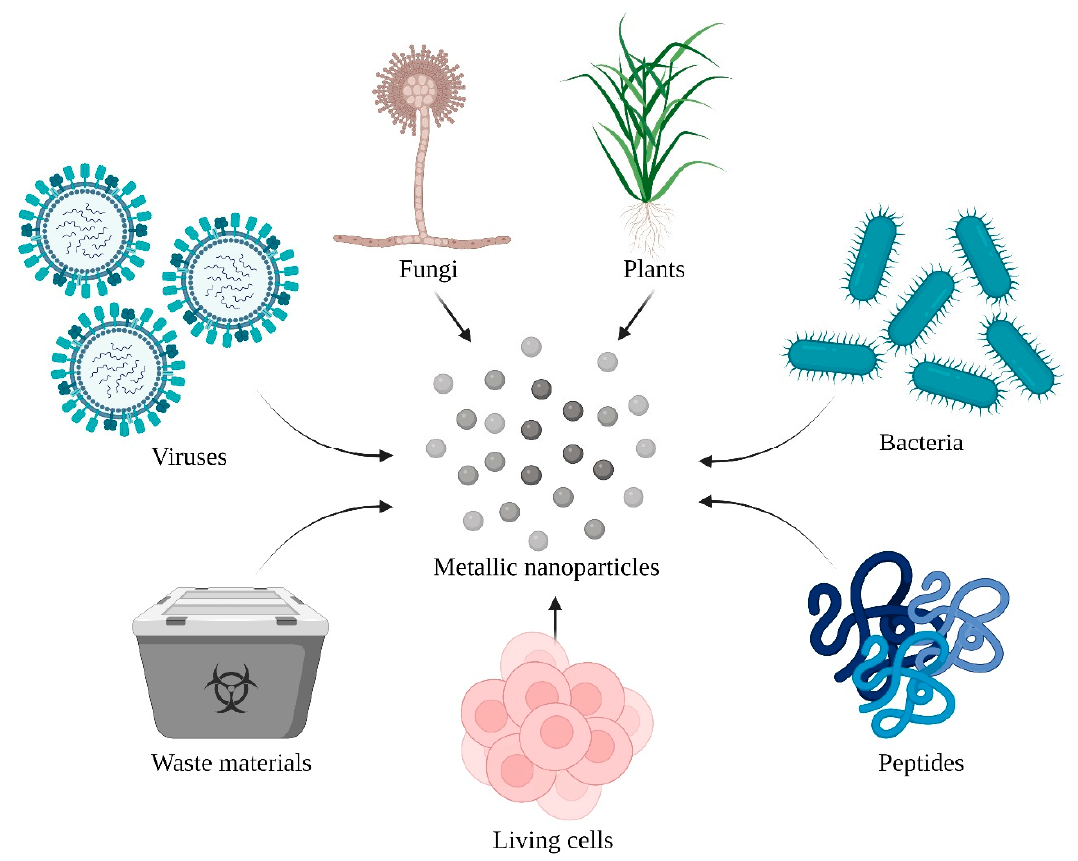
Figure 1. Various ways of achieving green synthesized nanoparticles. (Created with BioRender.com, accessed on 29 July 2022).